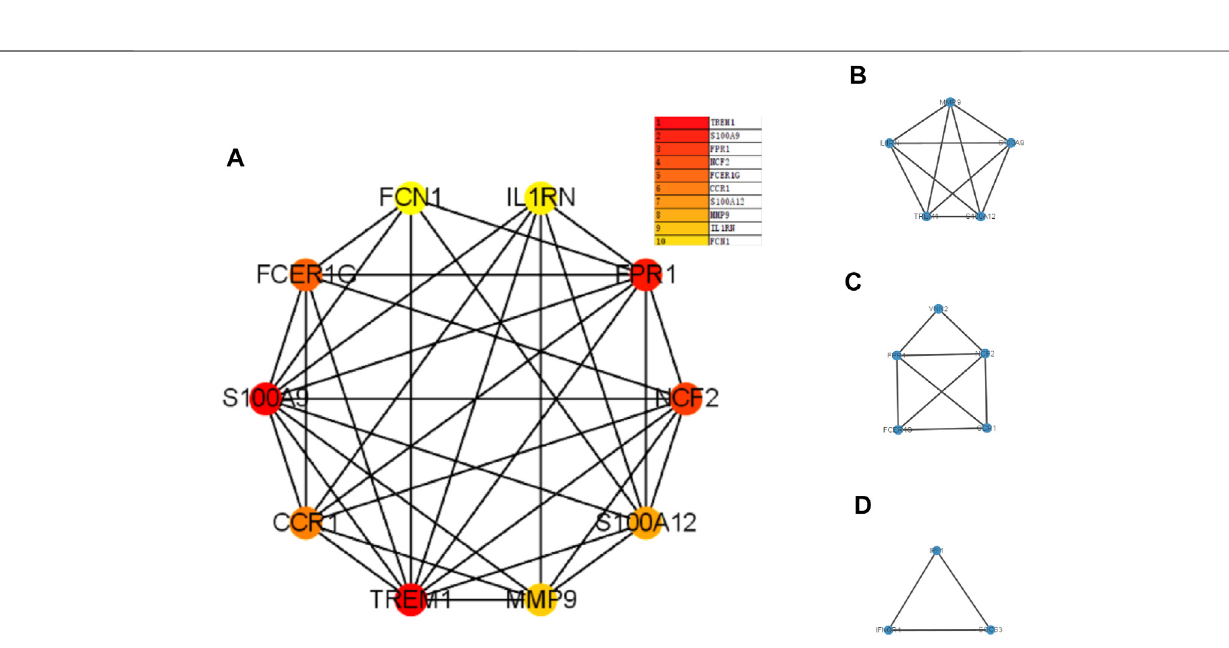
Frontiers in Molecular Biosciences |